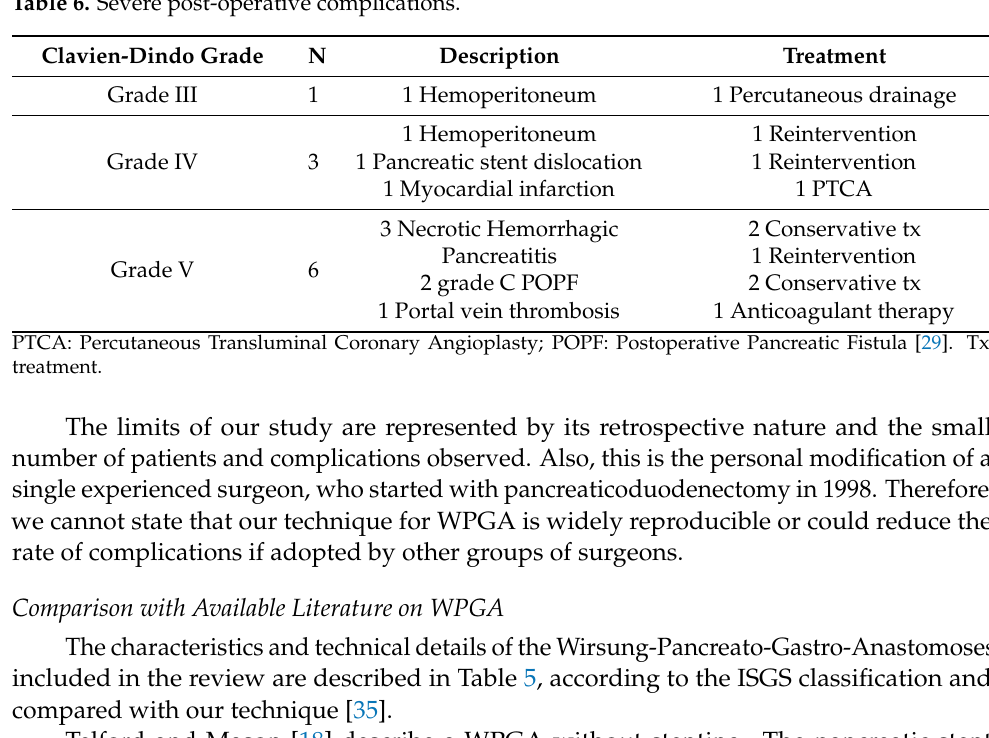
Table 6. Severe post-operative